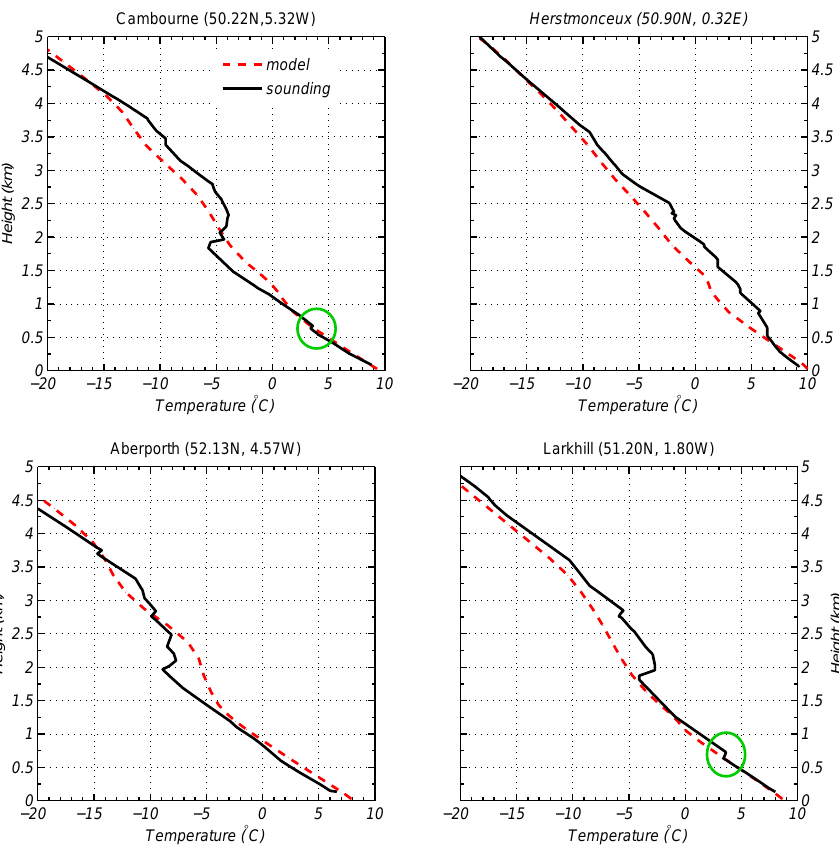
Fig. 8: Temperature profiles from radiosonde data (black) and the WRF model simulation (red) at selected locations. All profiles are taken at 12:00 UTC on the 22 January 2009. Note the small inversion just below cloud base at ∼ 750m in the Larkhill and Cambourne soundings (green circle).